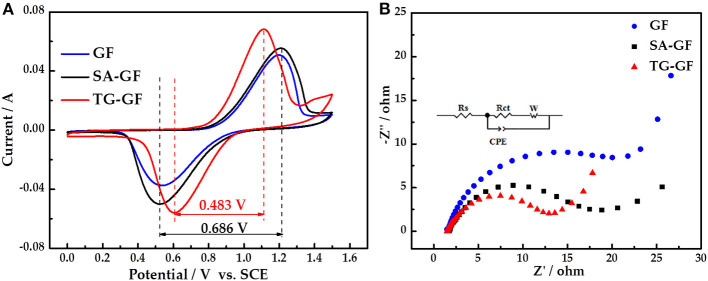
Cyclic voltammogram (CV) (A) and Nyquist plot (B) curves of graphite felt (GF), sulfuric acid-treated graphite felt (SA-GF), and thiourea-grafted graphite felt (TG-GF) in 0.1 M VOSO4 + 3 M H2SO4 electrolyte.